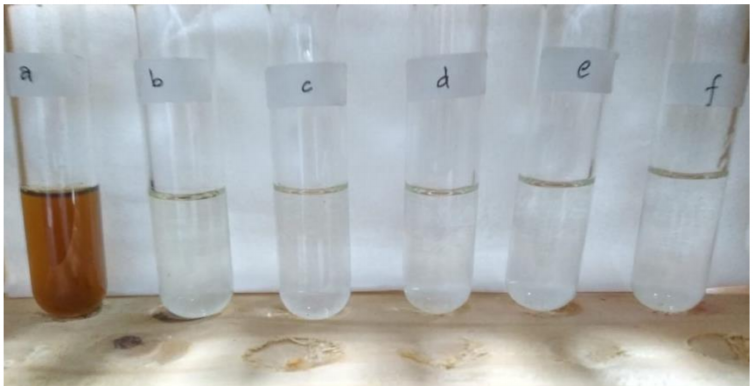
Figure 10. Water samples taken from ( a ) fresh batik wastewater and ( b ) after pretreatment, and per- meated feed samples from different membranes: ( c ) pristine PSf operating at a pressure of 12 bar, ( d ) PSf/PVP 0.15, ( e ) PSf/PVP 0.25, ( f ) PSf/PVP 0.35 operating at 5 bar,